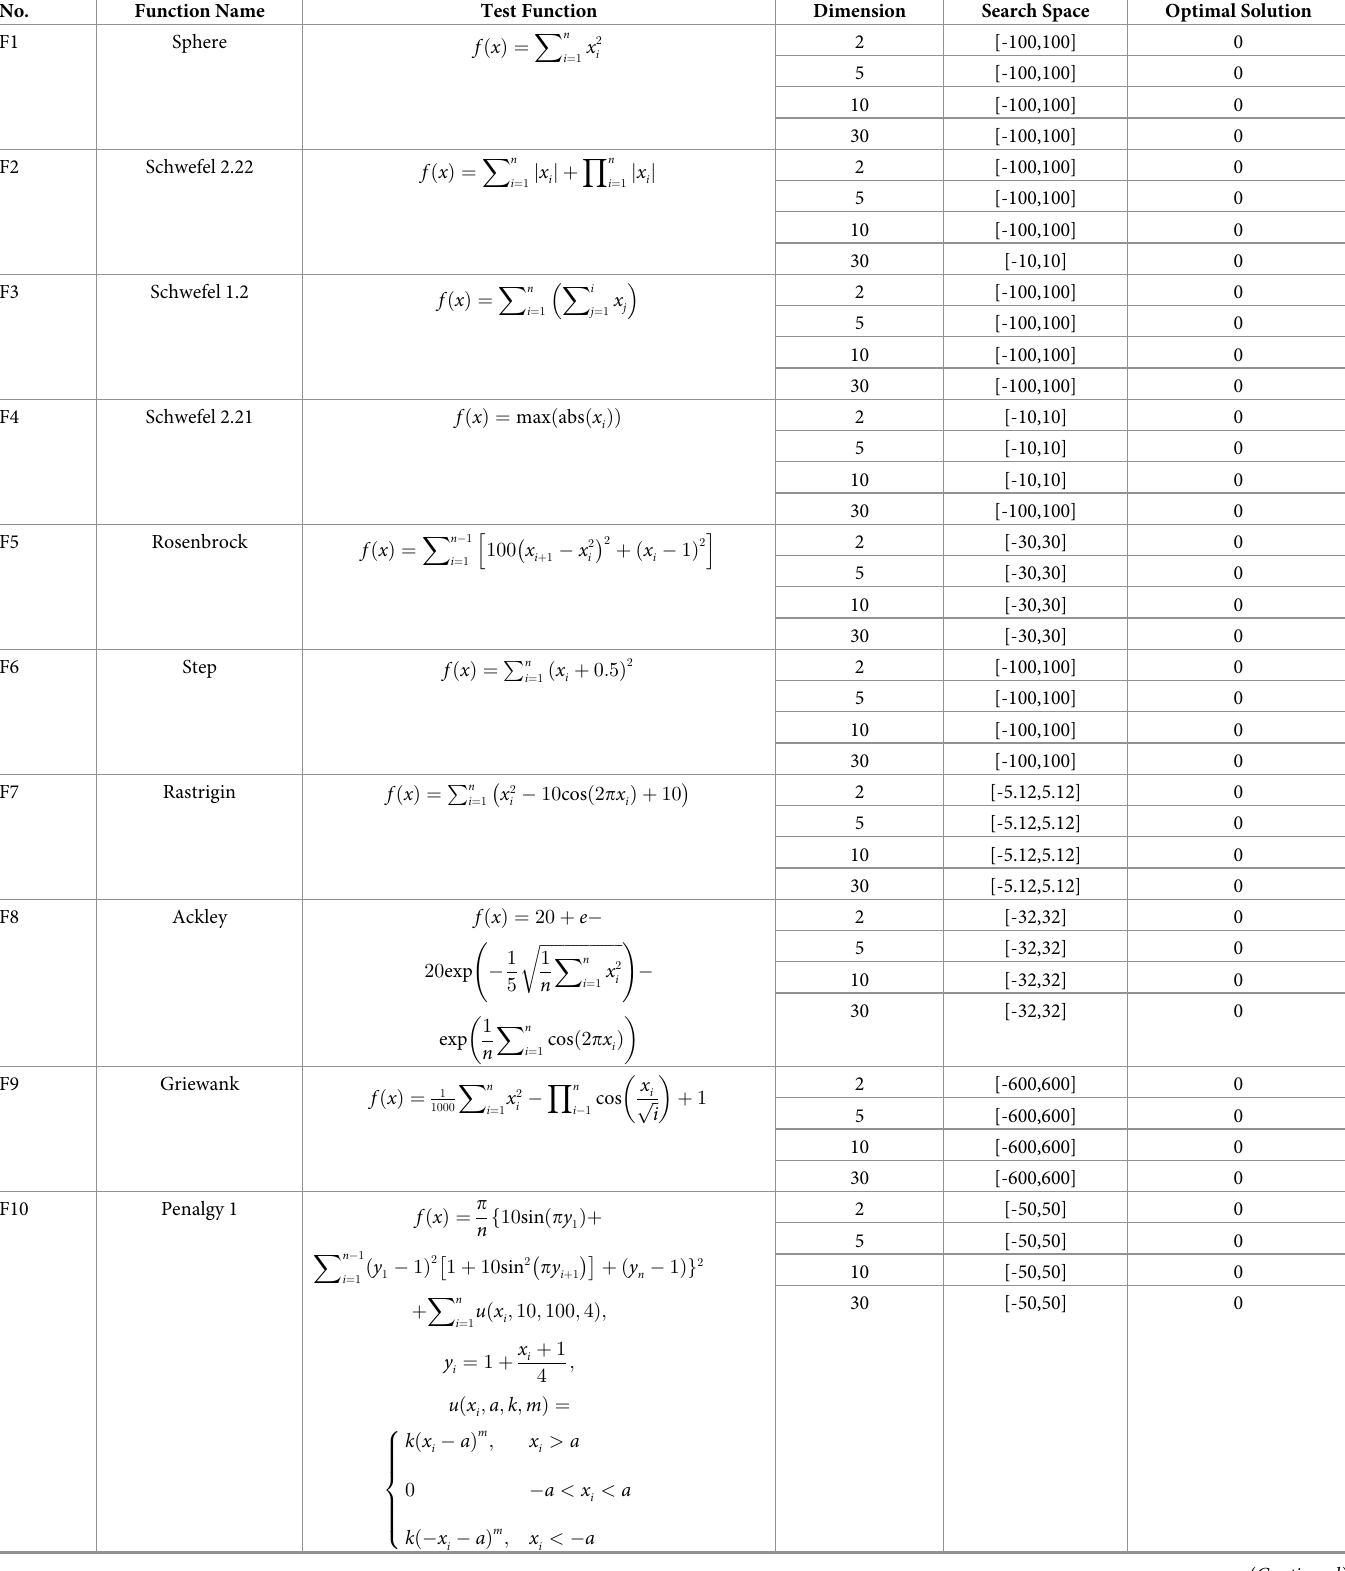
Table 2. The used test functions in the evaluation. No.